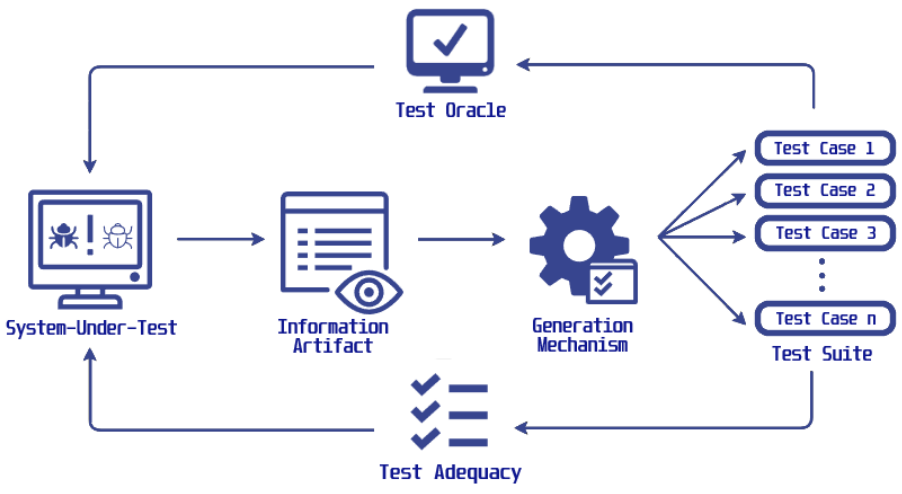
Figure 1. An overview of the testing process, adapted from [13] with permission from